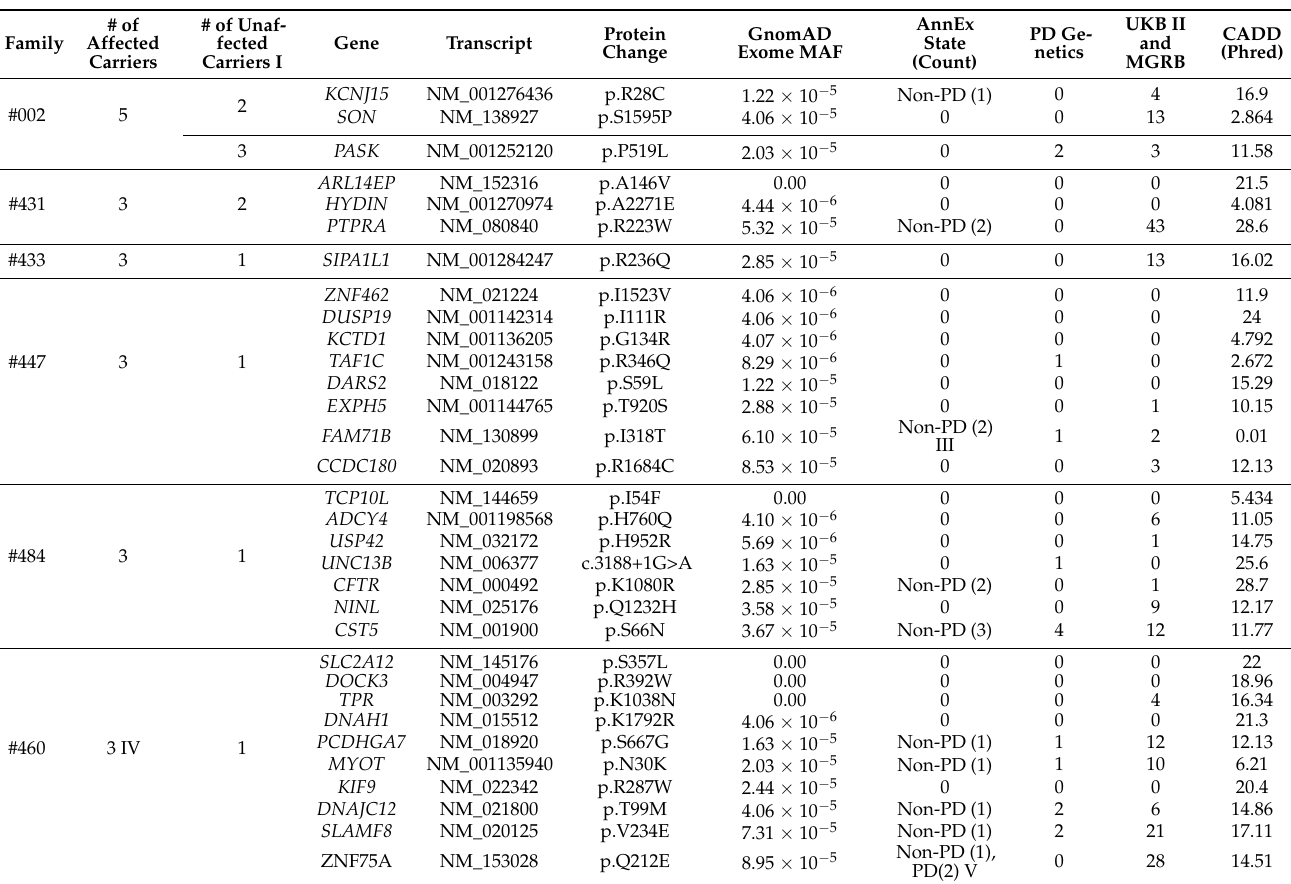
Table 1. Candidate Genetic